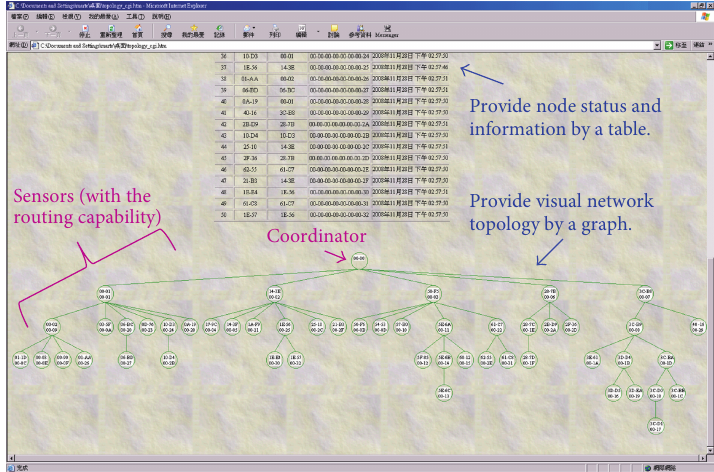
Figure 8: Node status and network topology monitored via